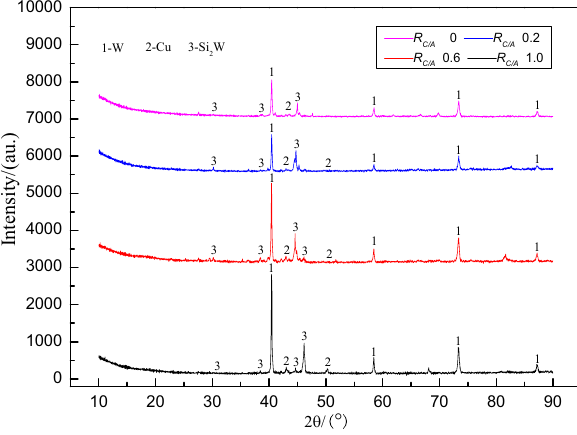
Figure 8: XRD patterns of the CuW composites obtained with dif - ferent R ( C/A )